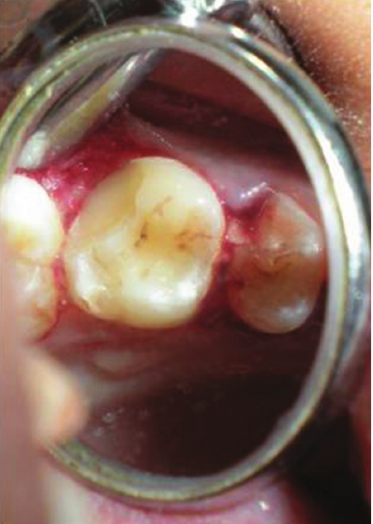
Figure 15: Buccal view of obliquely fractured 26 and 25, after reflection of the full thickness mucoperiosteal flap on the facial aspect. Relationship of fracture to remaining gingival tissues.